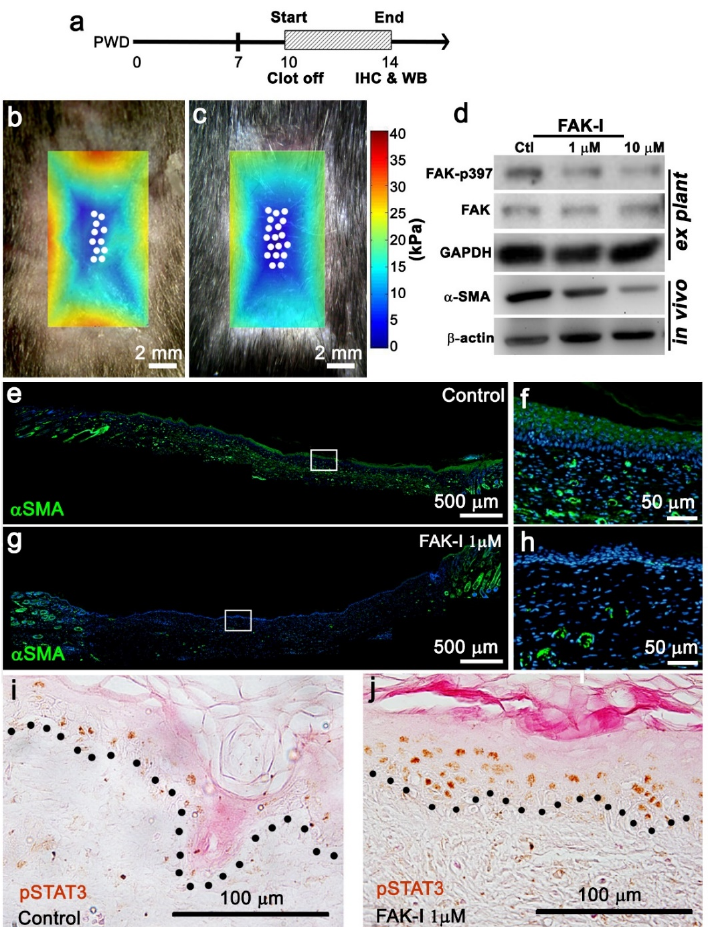
Figure 3. Reduced FAK activity alters the wound microenvironment resulting in enhanced wound- induced hair follicle neogenesis induction. ( a ) Timeline of topical 1 µ M FAK-I treatment for western blot or immunohistochemistry experiments. ( b , c ) Overly of AFM heatmap onto FAK-I treated wounds exhibiting lower stiffness, increased regenerative area, and greater WIHN (scale bar; 2 mm, white dots; de novo follicle positions). ( d ) Western blot of explant wound epidermis culture or in vivo wounds treated with FAK inhibitor showing FAK, FAKp397, and α -SMA expression. ( e – h ) Immunostaining of topically treated 1 µ M FAK inhibitor wounds showing α -SMA expression patterns (e.g., scale bar; 500 mm, f, h scale bar; 50 m, green; α -SMA, blue; Hoechst). ( i , j ) Immunostaining of topically treated wounds showed p-Tyr705-STAT3 expression patterns (scale bar; 100 mm, brown; p-Tyr705-STAT3, black dotted line; basal